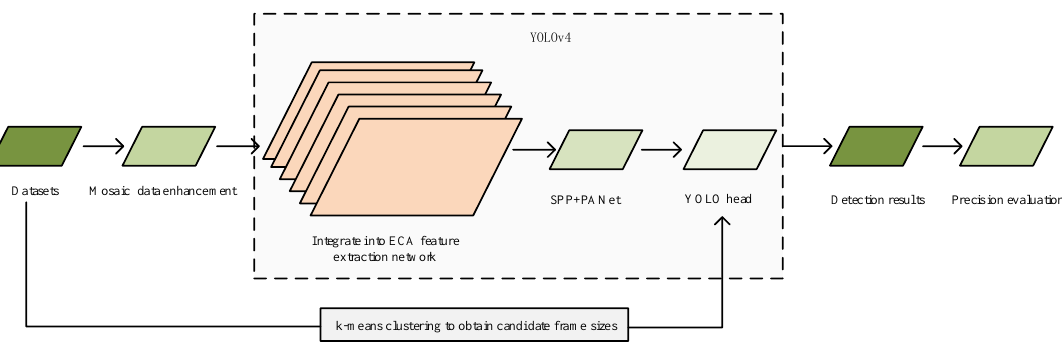
Figure 1. Flow chart of proposed method.